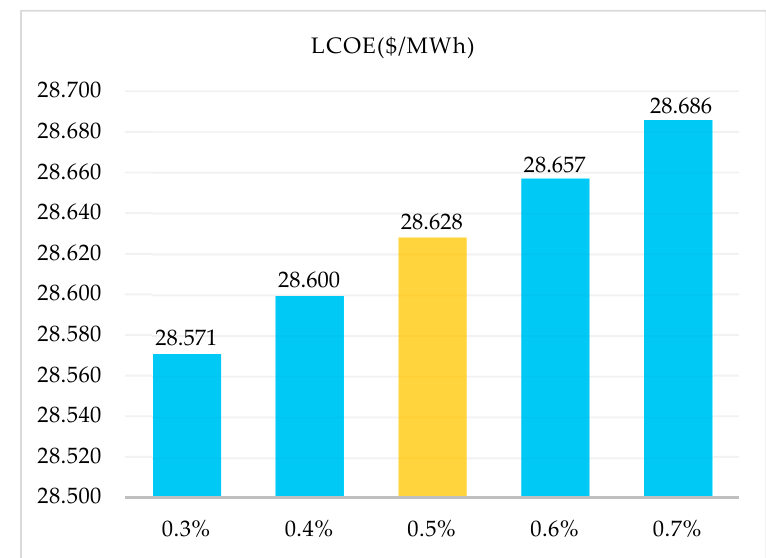
Figure 15. LCOE for reduction coefficient variations.